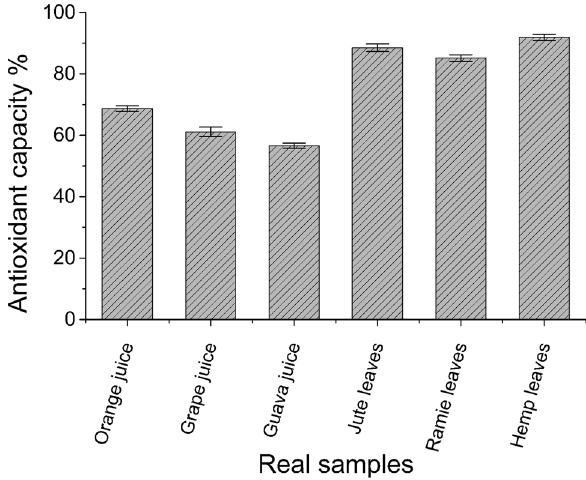
Figure 8: Determination of antioxidant capacities of fruit juices and plant extracts using